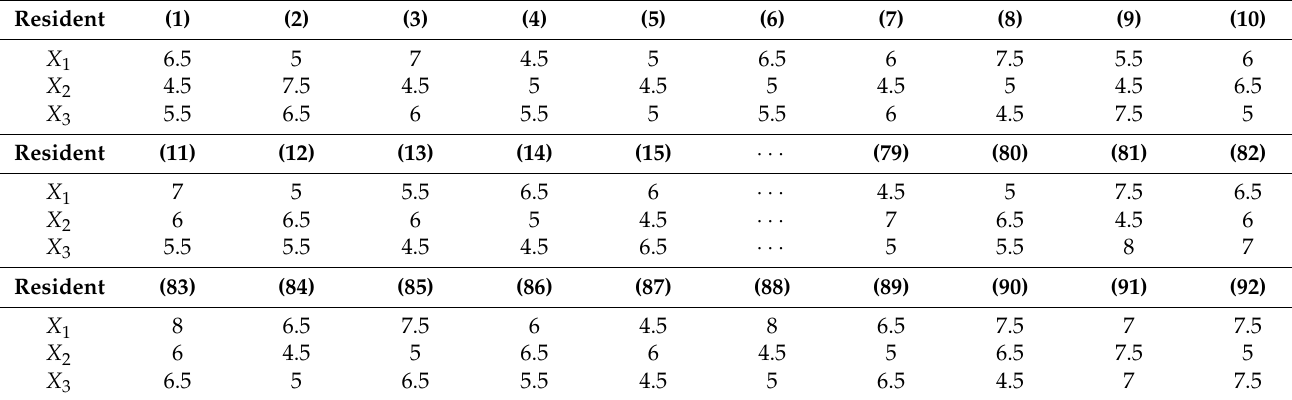
Table A4. Importance scores of three primary